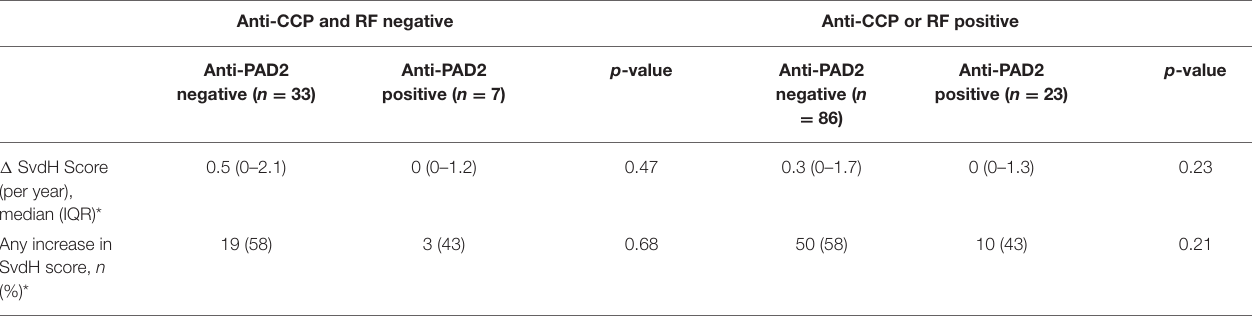
TABLE 2 | Progression of joint damage according to anti-PAD2 and anti-CCP/RF